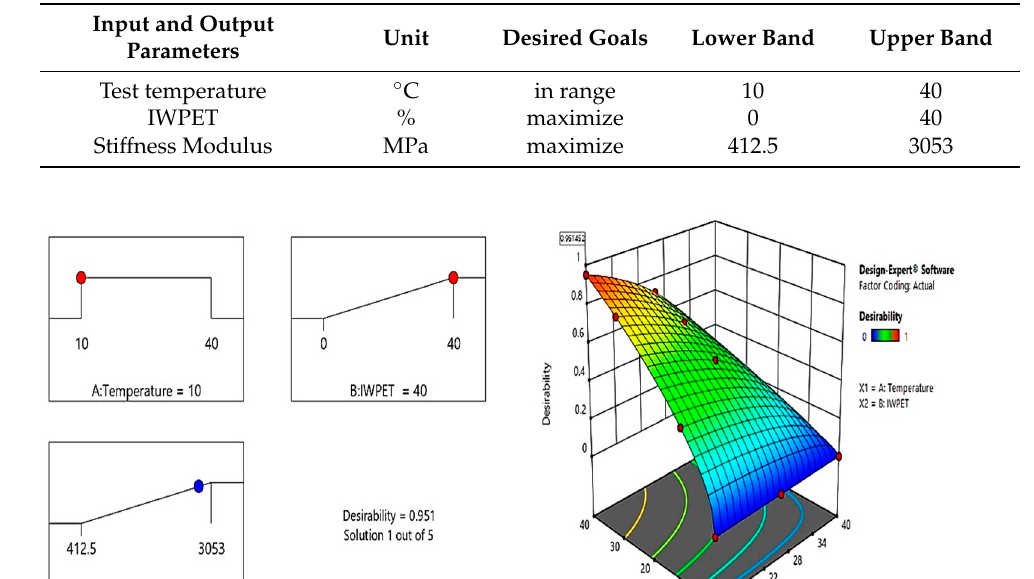
Table 7. Numerical optimization selected criteria for stiffness modulus response.